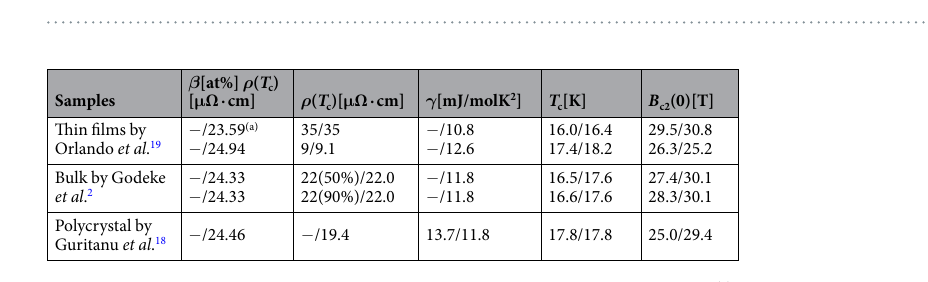
Figure 6. Temperature dependence B c2 ( T ) at varying Sn content in the range of the cubic phase at increment of 1 at% from 18 at% to 24 at% Sn. The insert figure represents the situation in the tetragonal phase for 0.2 at% increment between 24.2 at% and 25.4 at% Sn.